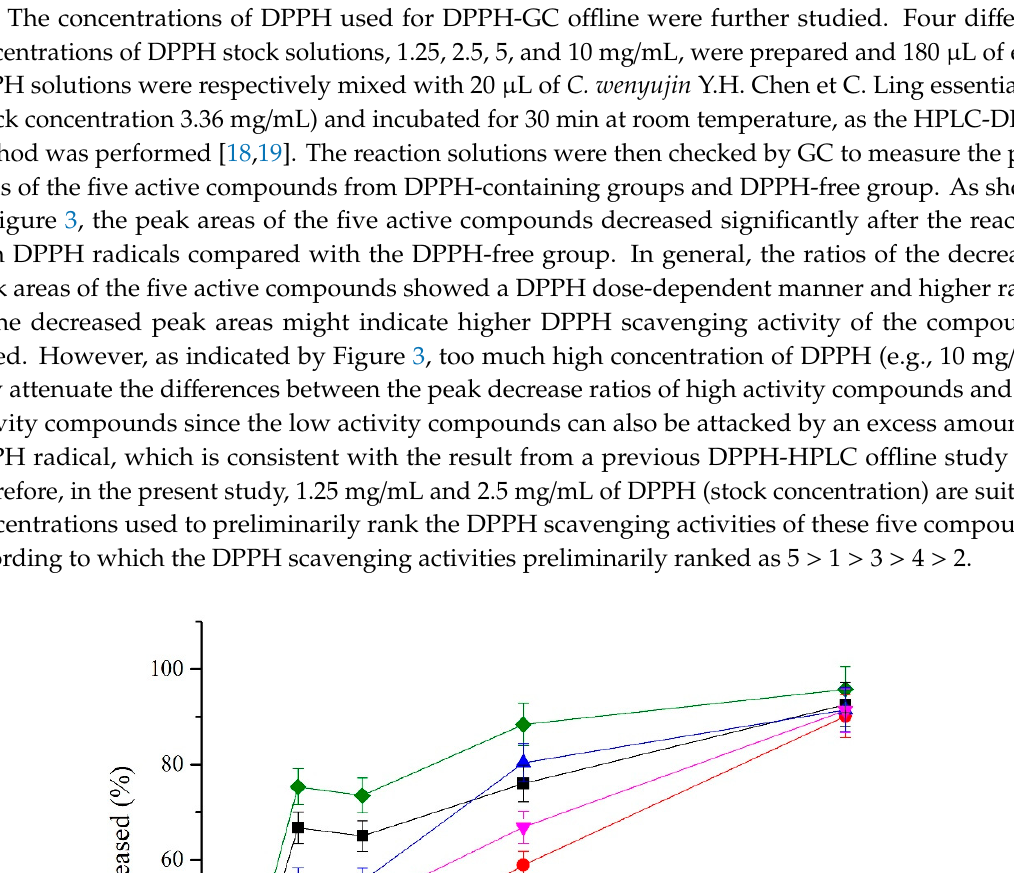
Figure 2. Chromatograms of the Curcuma wenyujin Y.H. Chen et C. Ling essential oil before and after reaction with DPPH radicals. Column: HP-5 phenyl methyl siloxane (30 m × 0.32 mm), column temperature programmed: inlet temperature 65 ℃ for 2 min, 5 ℃ /min to 90 ℃ , 90 ℃ for 3 min, 8 ℃ /min to 150 ℃ , 150 ℃ for 15 min, 12 ℃ /min to 180 ℃ , 180 ℃ for 3 min, 16 ℃ /min to 210 ℃ , 210 ℃